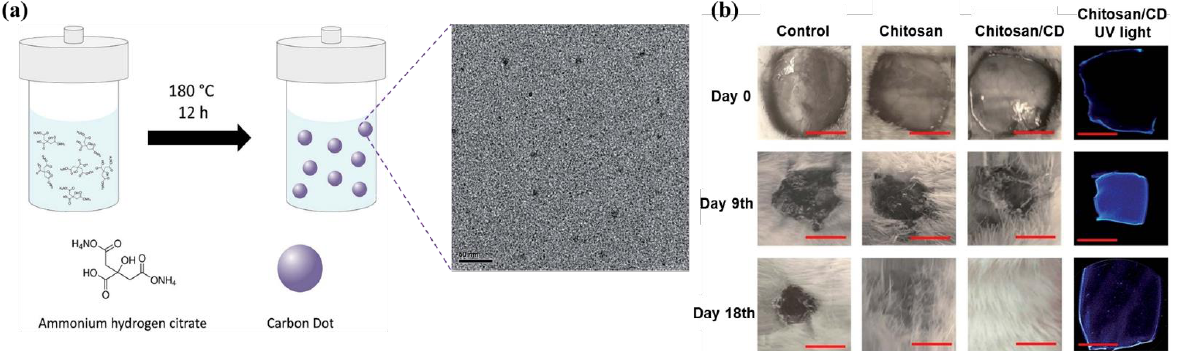
Figure 6. ( a ) Schematic illustration for synthesis of carbon dots and TEM images of CD; ( b ) The visual images of the untreated (control) and treated wound with chitosan, and chitosan/CD nanocomposite at different stages (0, 9, and 18 days); the fluorescence images at the right-hand side show the pH sensitivity of the chitosan/CD nanocomposite. Reprinted with permission from Ref. [92]. Copyright 2017, copyright with permission from Omidi and Yadegari.